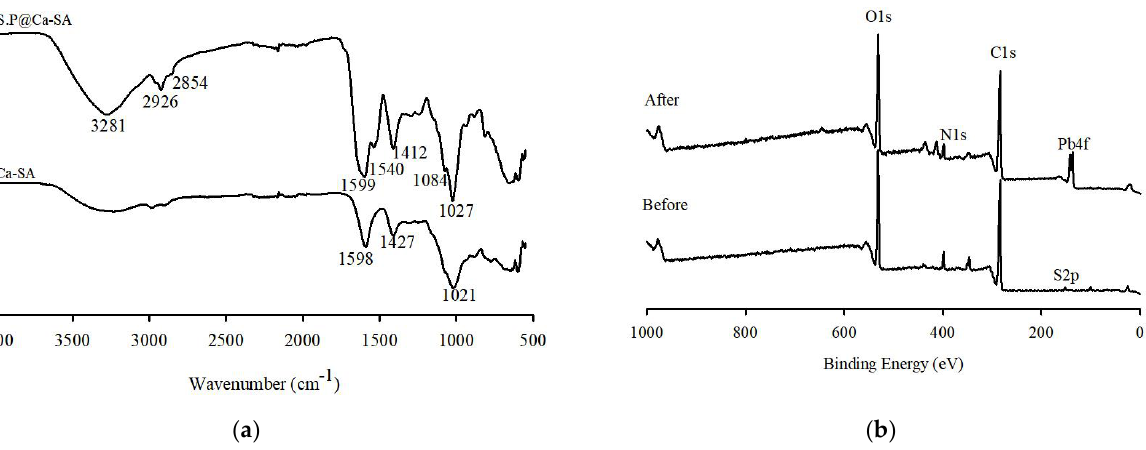
Figure 5. ( a ) FTIR of Ca-SA and S.P@Ca-SA. ( b ) XPS spectra of S.P@Ca-SA before and after adsorption.